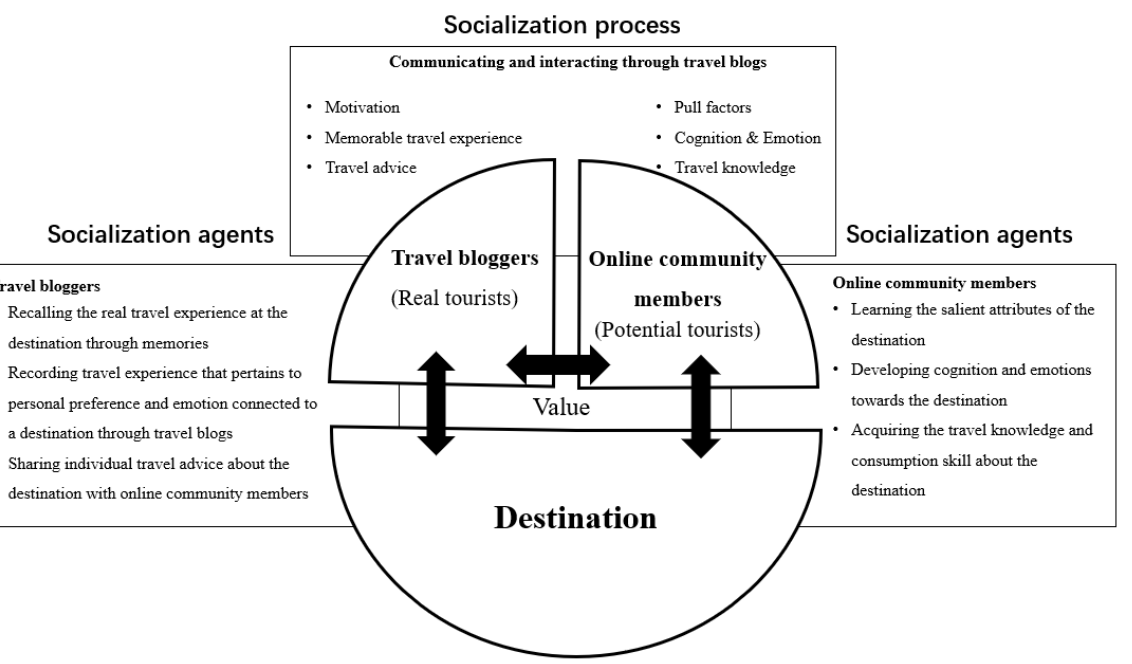
Figure 3. The co ‐ creation of destination value through travel blogs. Figure 3. The co-creation of destination value through travel